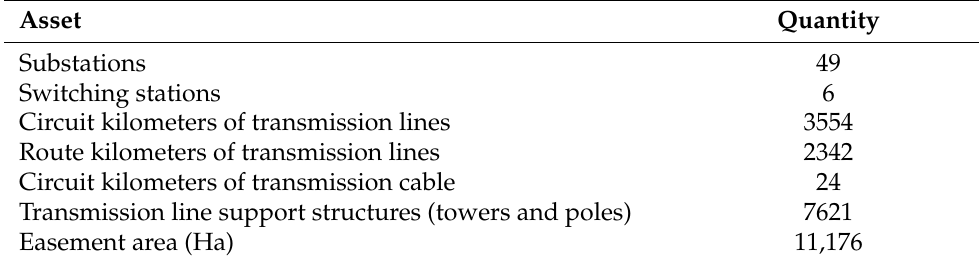
Table 1. Summary of the Tasmanian transmission